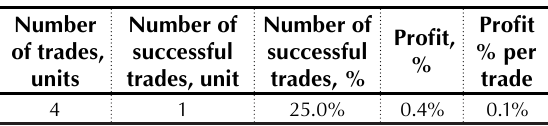
The results of the trading strategy for are presented in Table 12. Table 12. Trading simulation results for the PFST returns over the period 1991–2018: natural disasters,